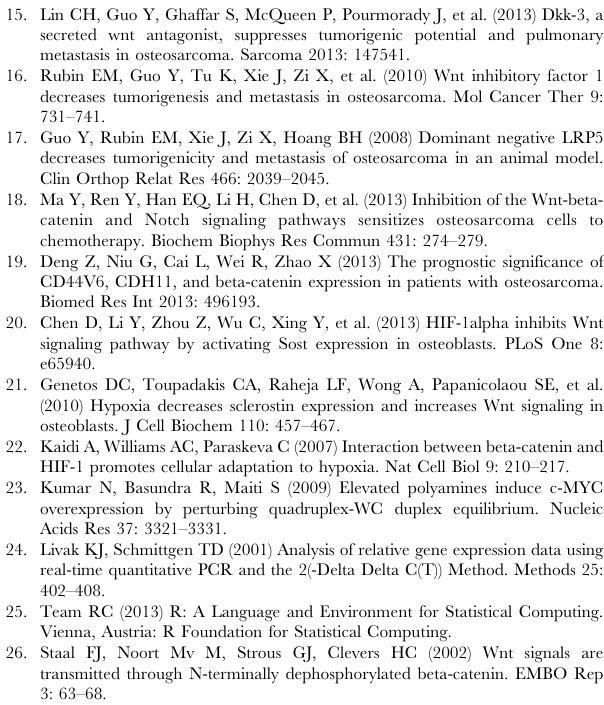
Figure S1 Quantification of HIF protein levels under hypoxia. Western blots from two independent experiments culturing MNNG/HOS cells under hypoxia for different time periods were quantified using ImageJ software. Band intensity is shown relative to b -tubulin. Figure S2 Quantification of active b -catenin protein levels under hypoxia. Western blots from two independent